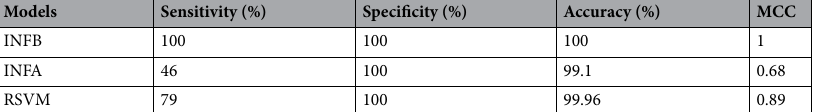
Table 3. Summary of performance measurement of the profiles. INFA anti-Influenza A virus, INFB anti- Influenza B virus, RSVM anti-Respiratory syncytial virus, MCC Matthews correlation coefficient.